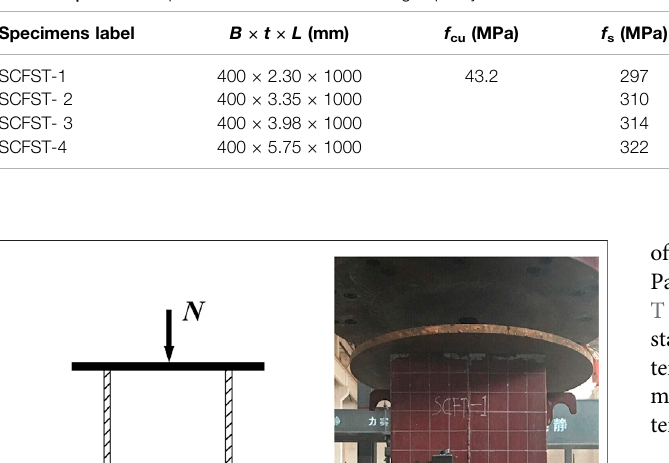
TABLE 1 | Details of specimens and their load-bearing capacity.